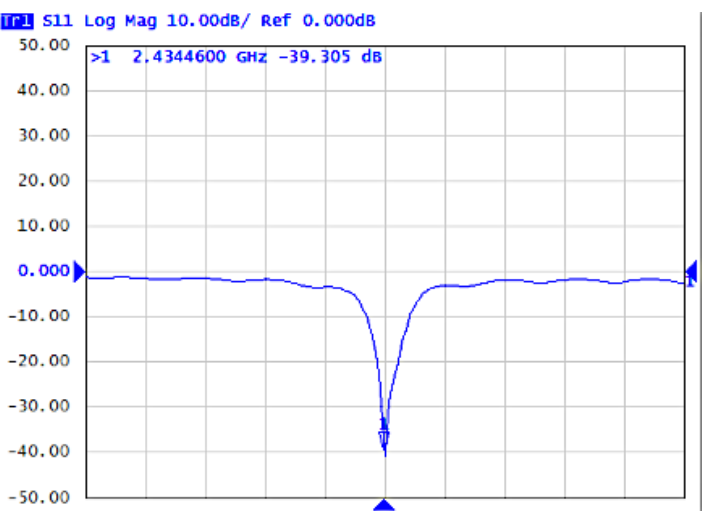
Figure 13. Parameter S 11 array 2 × 1 measured.